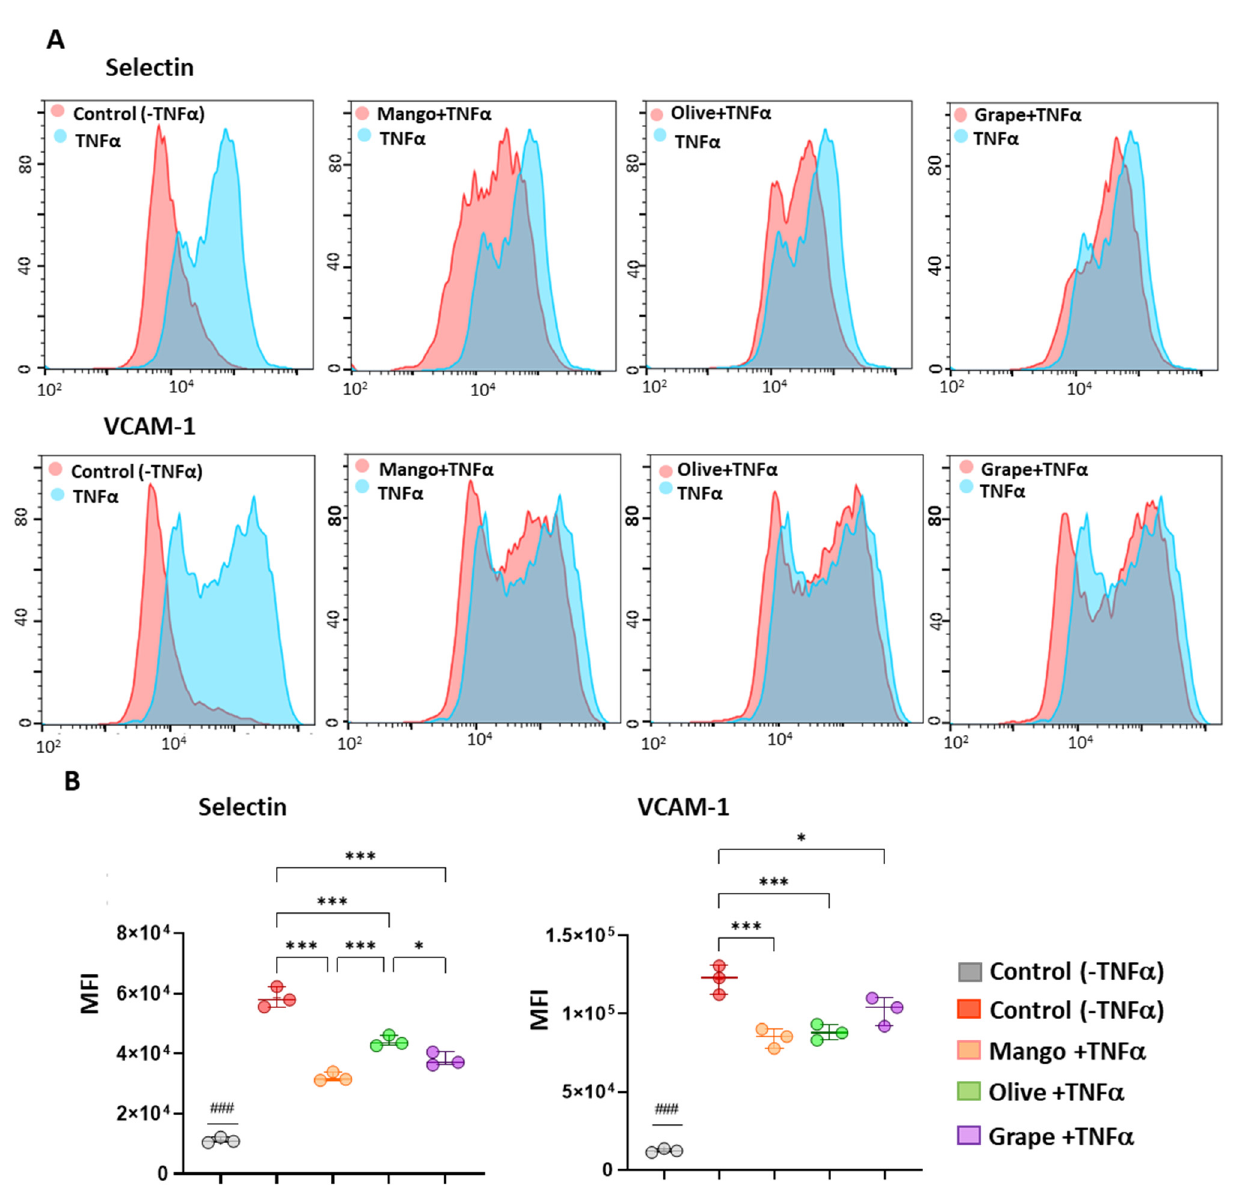
Figure 5. Anti-inflammatory effect of selected extracts. ( A ) Representative histograms of the effect of treatment with TNF α alone and TNF α with the mango (4.99 μ g/mL), olive (46.67 μ g/mL), and grape (16.67 μ g/mL) ethanolic extracts on the expression of the adhesion molecules E-selectin and VCAM-1, at 4 h. ( B ) Box and whisker diagrams of the effect of selected extracts on the expression of adhesion molecules. MFI: Mean Fluorescence Signal. ### Significant differences with respect to the control condition (-TNF α ). * Significant differences between the conditions. * p < 0.05; *** p <